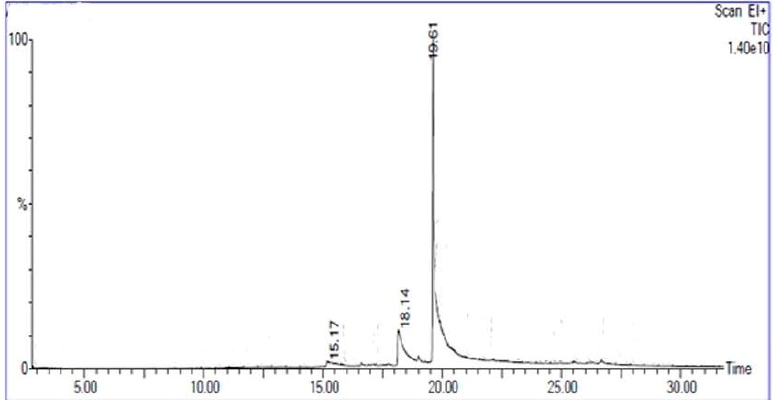
Figure 8. Gas chromatography profile of fatty acid methyl ester showing a major peak with retention time of 19.61 min.